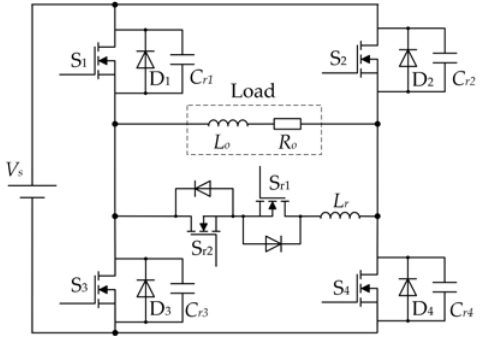
Figure 1. The circuit of auxiliary resonant sunbber inverter.